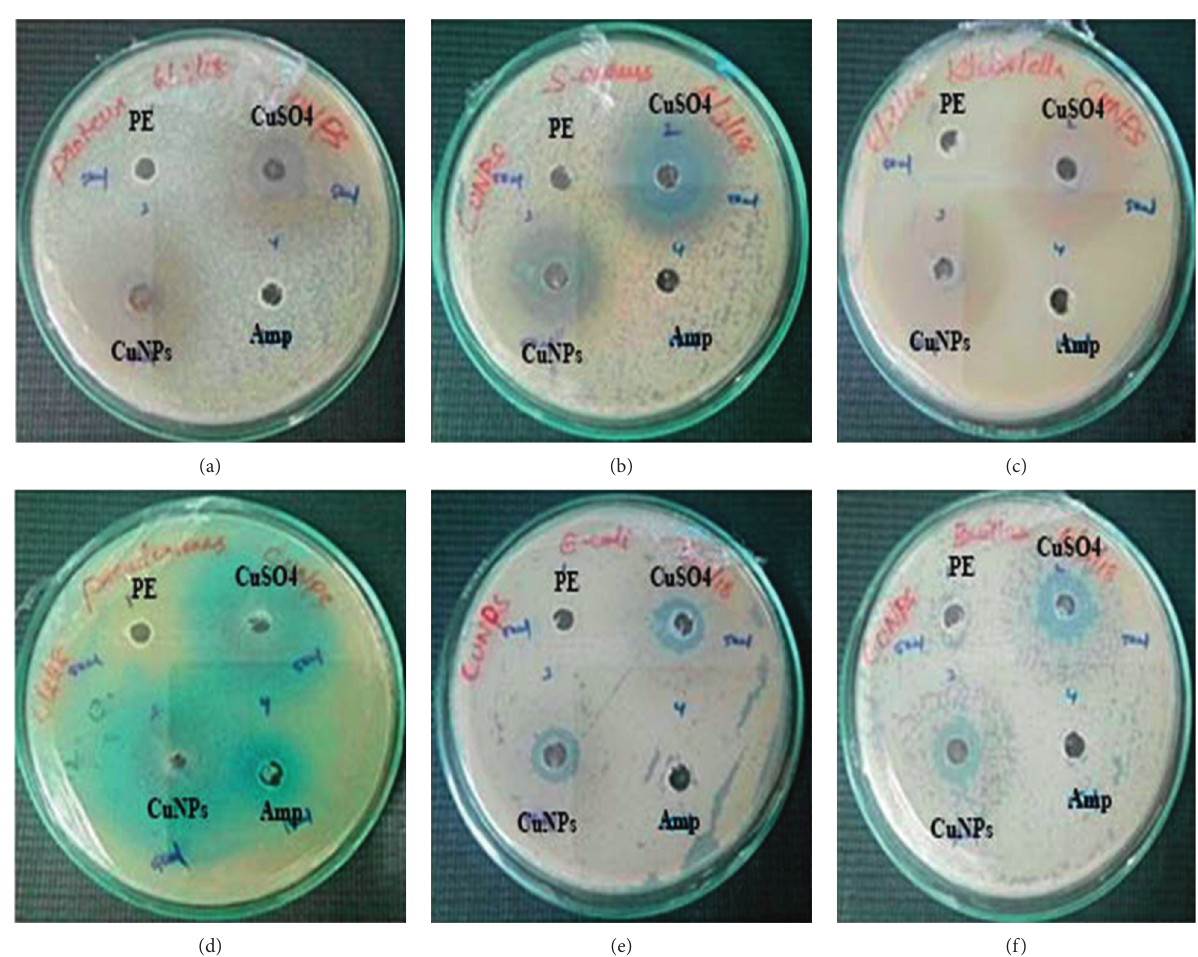
Figure 7: Antibacterial activity of copper nanoparticles. (a) Proteus , (b) S. aureus , (c) Klebsiella , (d) Pseudomonas , (e) E. coli , and (f) Bacillus